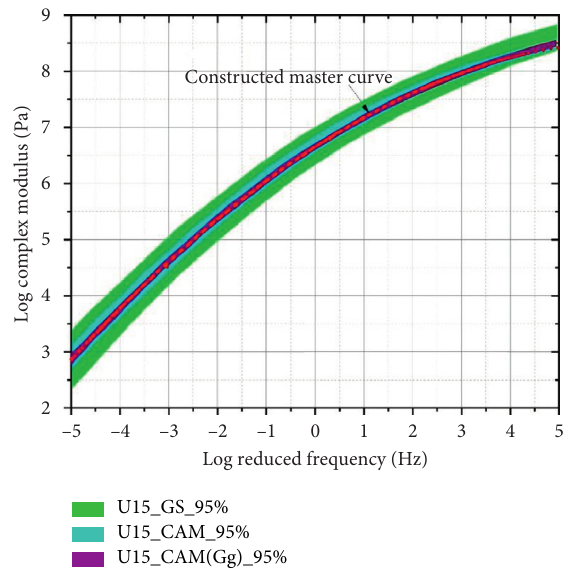
Figure 5: Master-curve bands constructed using different